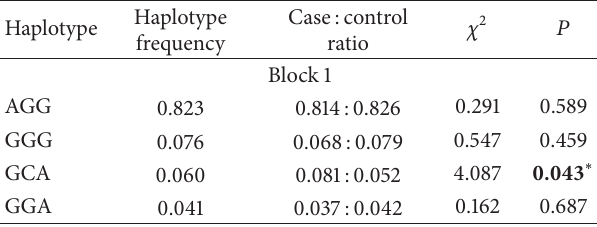
Table 6: Comparison of haplotype frequencies for the analysed AVPR1b polymorphisms between patients with suicide attempts and the control